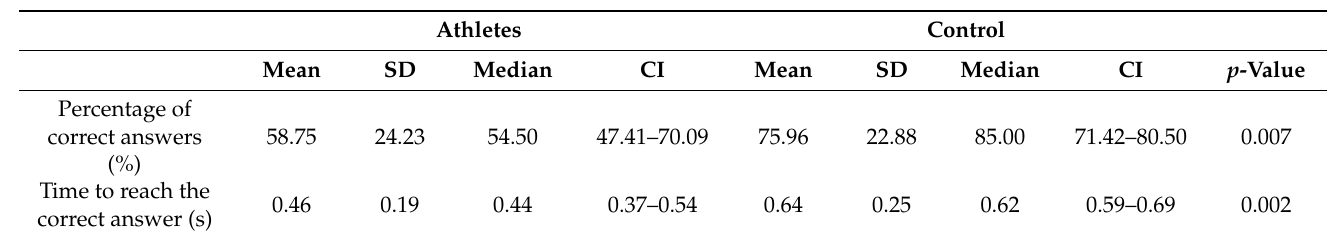
Table 1. “Directional arrows” test results.